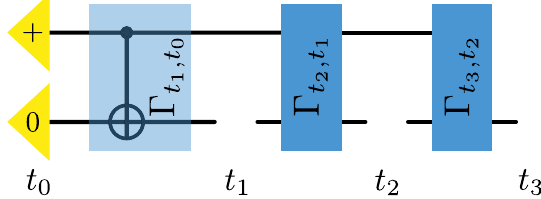
FIG. 14. Non-NDGD dynamics that leads to classical